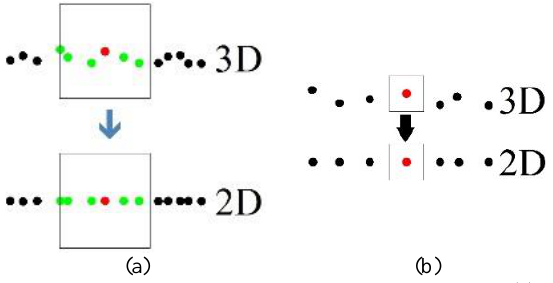
Figure 5 . The cube dimensions are greater than density (a) or less than density (b). The green points are the points inside the cube. The black points are the points outside the cube.